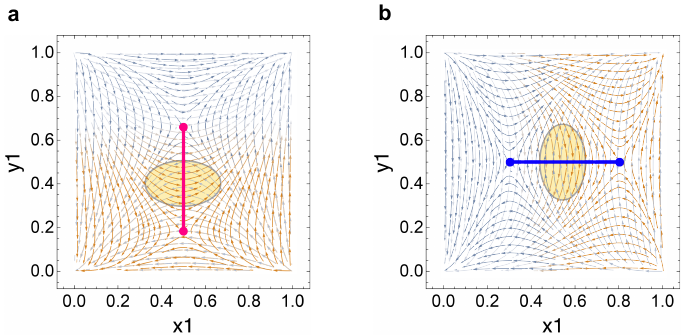
Figure 17. Vertical and horizontal attractor arc and trapping zone slopes. ( a ) Attractor arc using theoretical payoff pair, see Figure A7 in Appendix B. When the attractor arc is oriented vertically, the slope of the trapping zone becomes horizontal and perpendicular to the arc. ( b ) Attractor arc using theoretical payoff pair, see Figure A8 in Appendix B. When the attractor arc is oriented horizontally, the slope of the trapping zone becomes vertical and perpendicular to the arc. The opaque yellow ellipse is a background element to indicate the general region of the trapping zone. The evolutionary trajectories in both ( a , b ) trapping zones are orthogonal to their respective arcs.